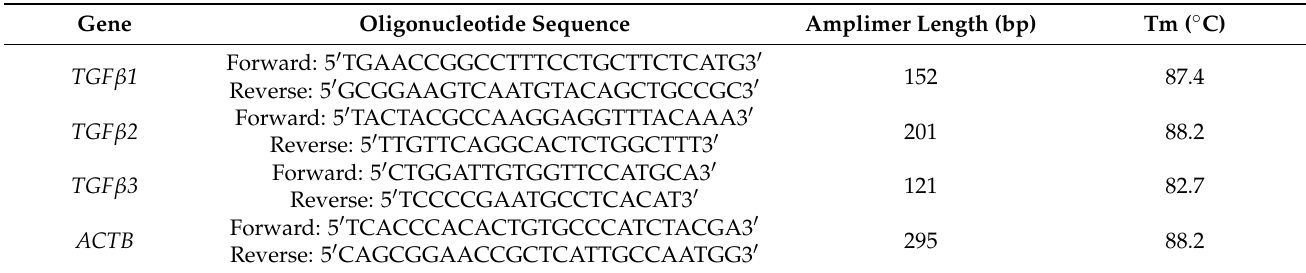
Table 2. Sequences of primers used in the RT-qPCR